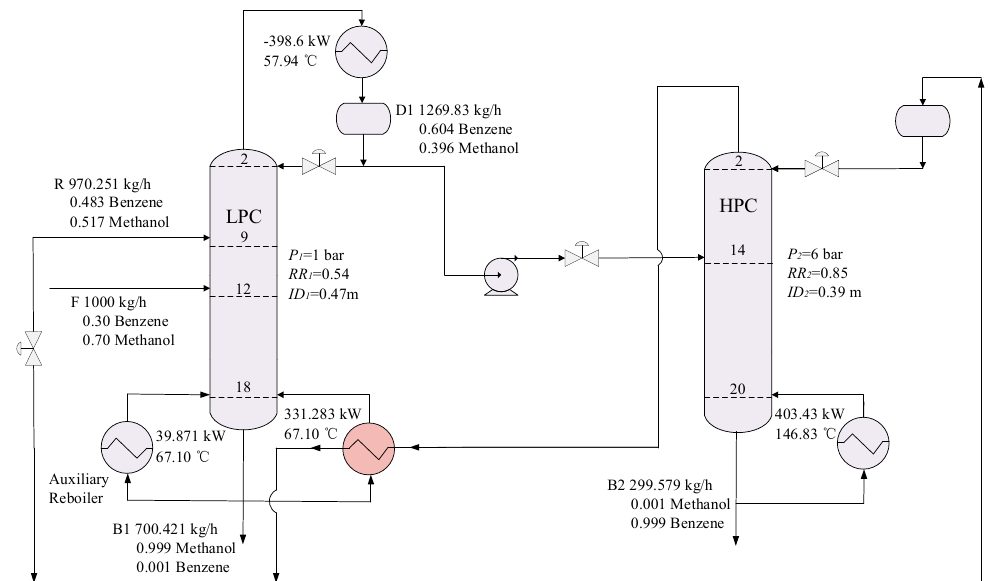
Figure 5. Flowsheet of the best optimal partial HIPSD process.